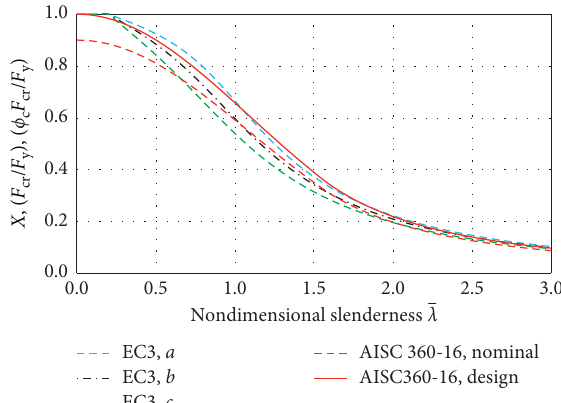
Figure 2: Comparison of the nominal and design buckling curves for AISC 360-16 (denoted as “AISC 360-16, nominal” and “AISC 360-16, design” in the graph) with three buckling curves a, b, and c defined in EC3 (denoted as “EC3, a,” “EC3, b,” and “EC3, c” in the graph).